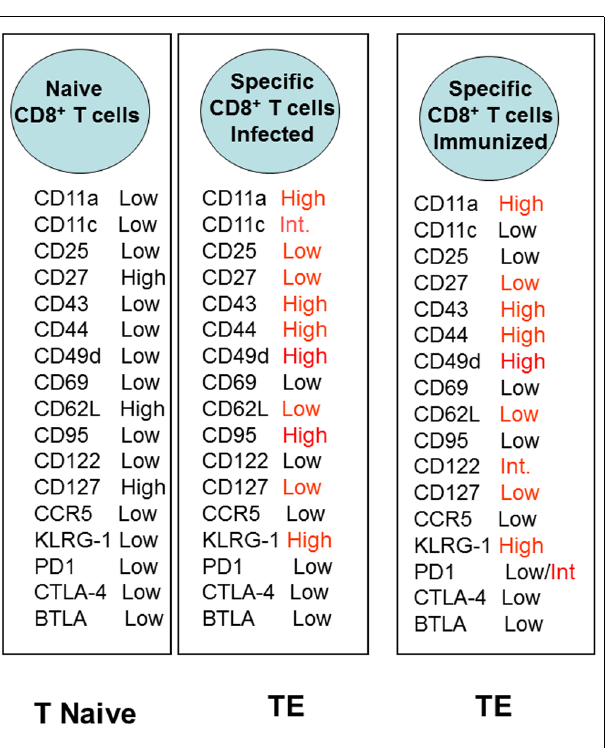
FIGURE 2 | Expression of distinct adhesion/activation receptors on the surface of specific CD8 + T cells elicited by either T. cruzi infection or recombinantAdHu5 immunization (Vasconcelos etal., 2012). Mice were infected s.c. with T. cruzi (150 blood stream trypomastigotes) or immunized i.m. with AdHu5 (2 × 10 8 pfu) expressing the gene encoding the amastigote surface protein-2 of T. cruzi 19 days